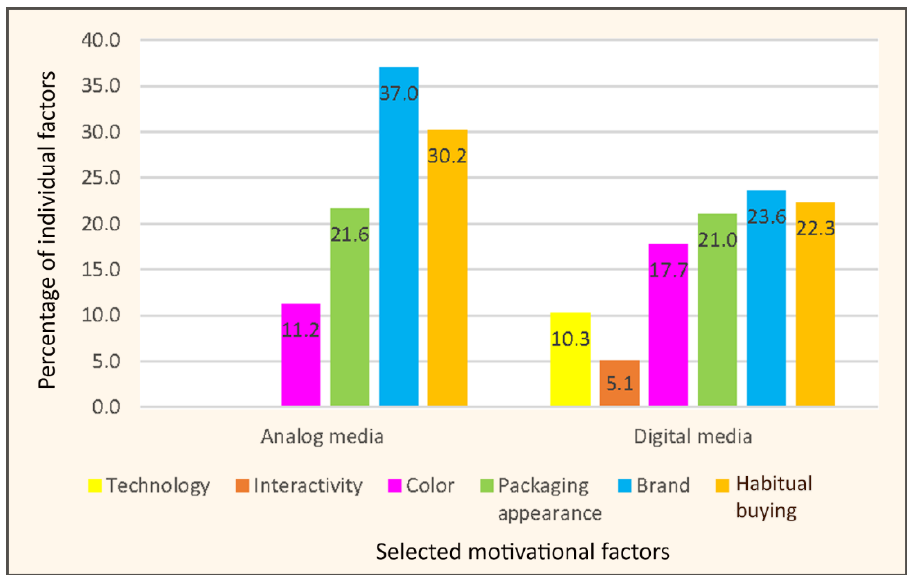
Figure 7. Comparison of motivational factors for product selection between analog and digital media in percentage values.